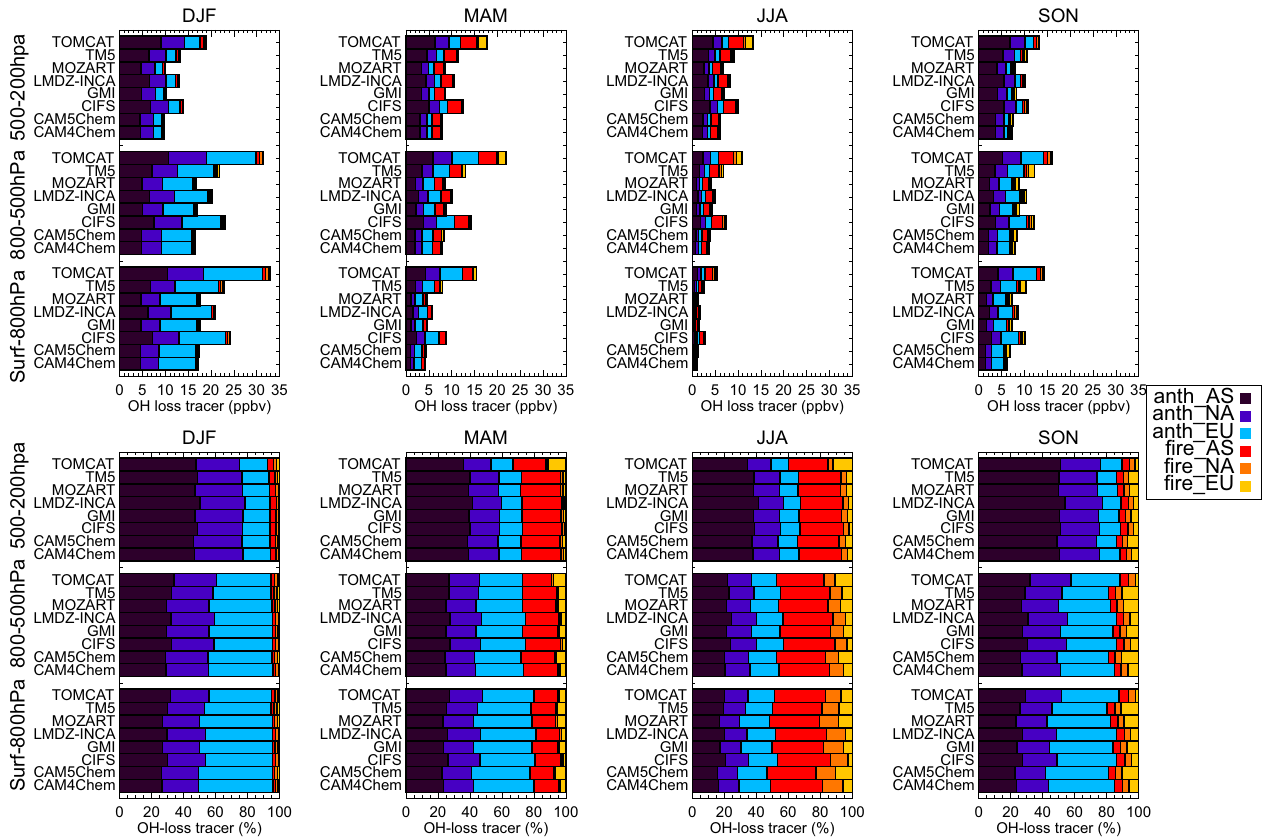
Figure 15. Seasonal mean 2008 regional OH-loss anthropogenic and biomass burning regional tracers averaged over three different altitude bands at latitudes north of 66 ◦ N. Contributions shown as absolute concentrations (top) and as a percentage of the total CO tracer (bottom; AS–Asian tracer, NA–North American tracer, EU–European